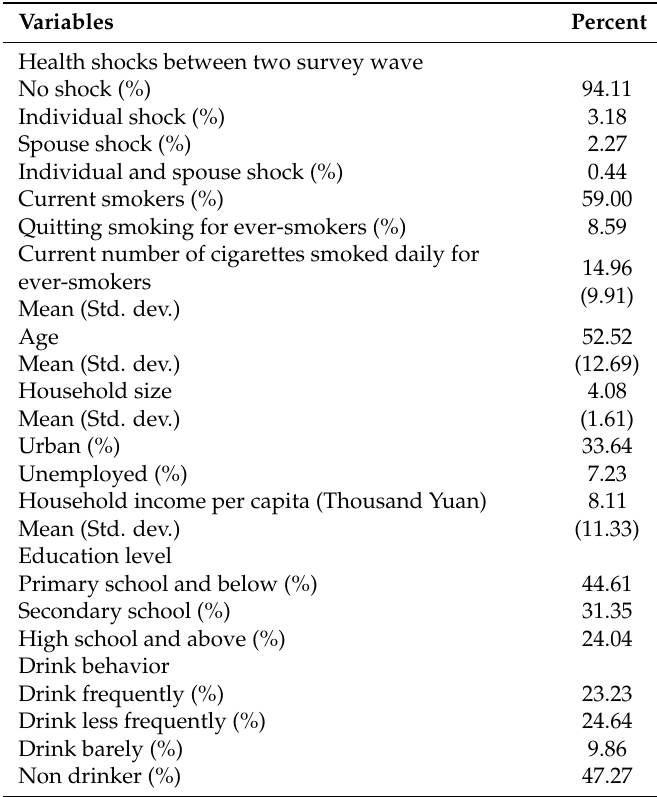
Table 1. Respondents’ socioeconomic and life style